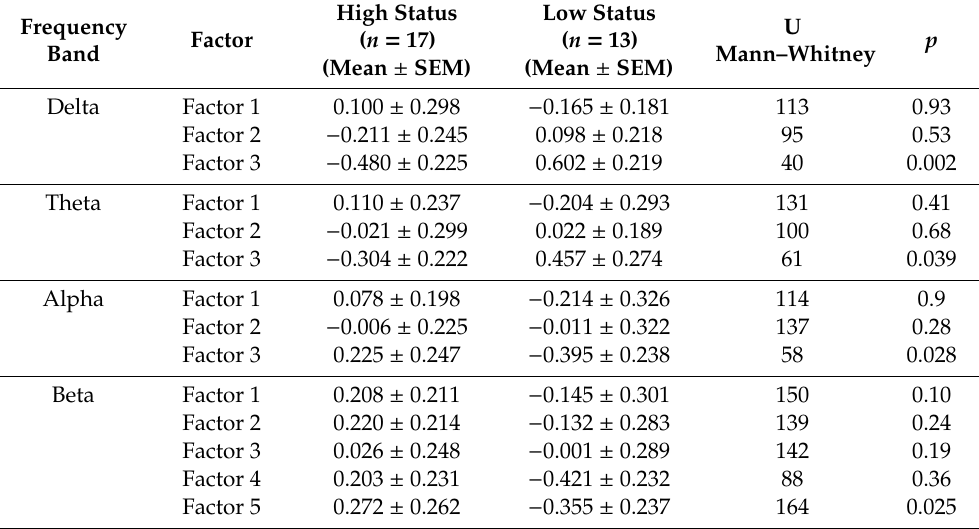
Table 1. Z Absolute power values of each factor separately by frequency bands.